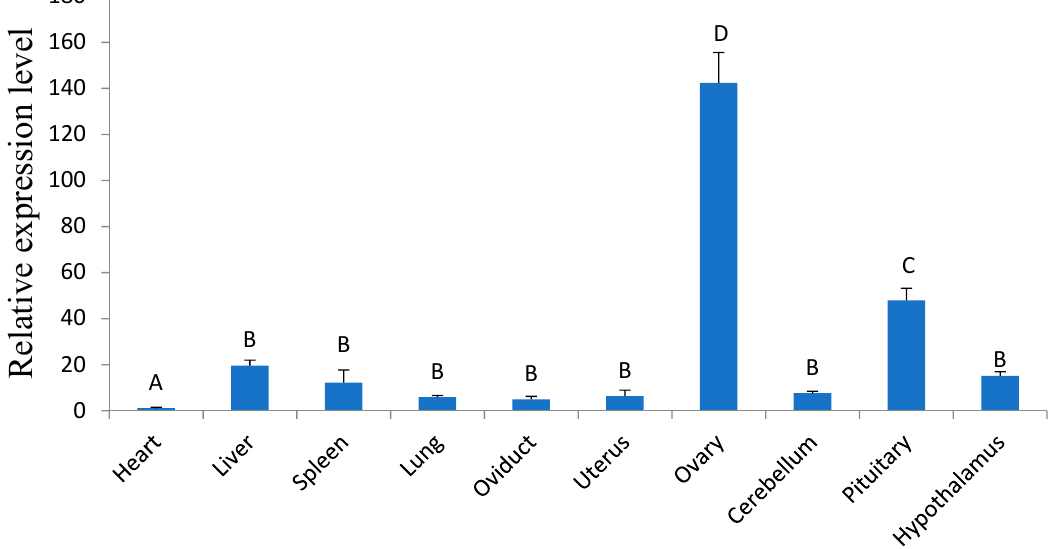
Figure 1. The tissue expression pattern of ovine GDF9 . The real-time PCR results, the results were expressed as the means ± SD, the different letters above the bars represent significant differences (Relative to the heart group of A, B, and C represent p < 0.01, D represents p < 0.001. Among B, C, and D differences represent p < 0.01).